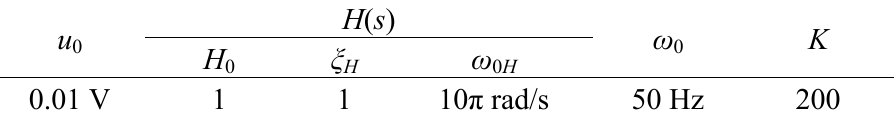
Table 2. Parameters of the MPPT based on ESC.